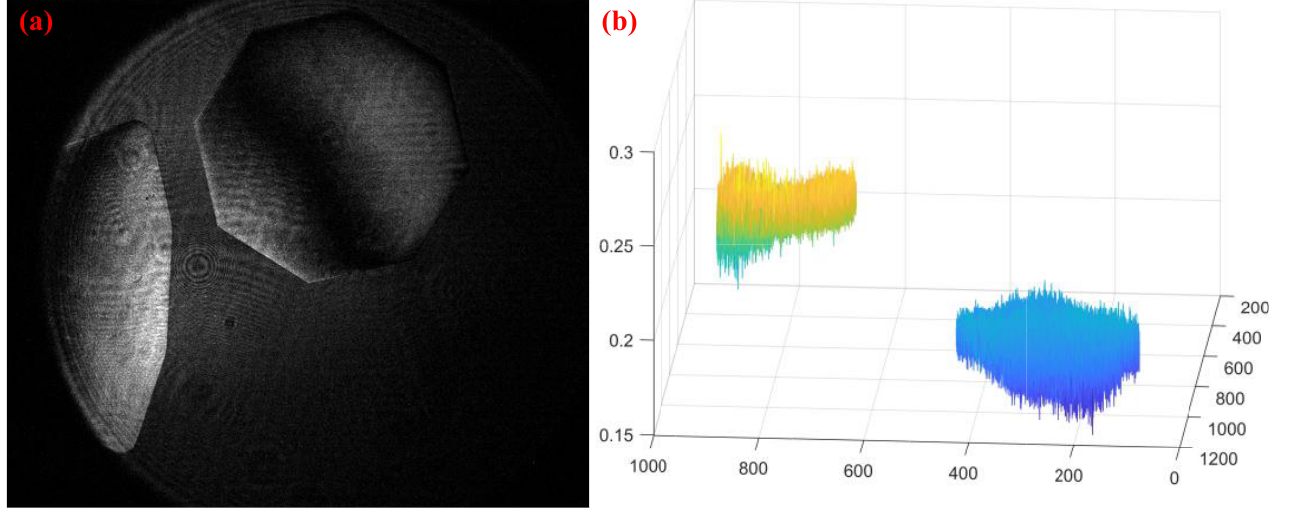
Figure 6. Schematic of the interference fringes ( a ) and wavefront data ( b ).